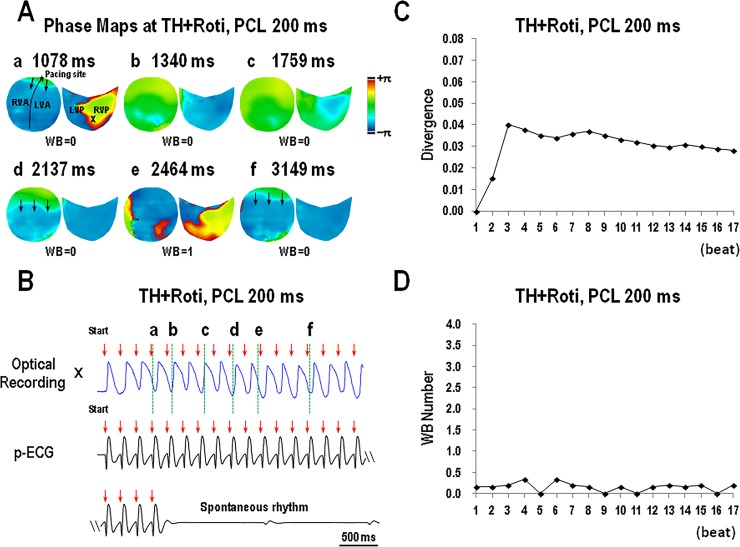
Simultaneous recordings of epicardial activations (A), pseudo-ECG (B), dynamic changes of divergence (C), and epicardial wavebreaks (D) at the start of burst ventricular pacing at pacing cycle length (PCL) 200 ms during therapeutic hypothermia (TH, 30°C) in an episode of low divergence (data is from heart #7). Note that the divergence increased to 0.040 at the 3rd beat and decreased to 0.028 at the 17th beat. VF was not inducible in this episode (B). Black triangles in panel A indicate points of wavebreaks (WBs).